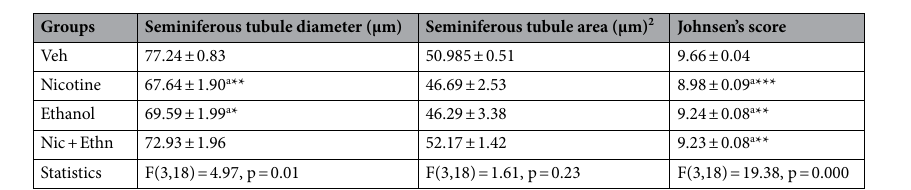
Table 2. The effects of exposure to nicotine and ethanol, either alone or simultaneously, during in utero life and breastfeeding periods on the averages of Johnsen’s score and seminiferous tubules diameter and area in the testicular tissue of F1 adult pups. Superscript letter (a) indicates a significant difference compared to the vehicle group. *, ** and *** indicate p ≤ 0.05, p ≤ 0.01 and p ≤ 0.001, respectively. Data present Mean ± SEM.